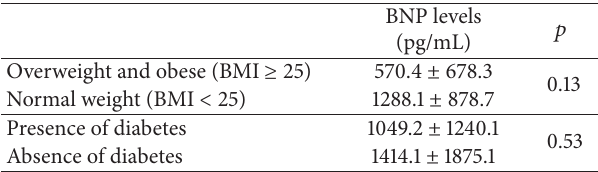
BNP levels 𝑝 (pg/mL) 0.13 0.53